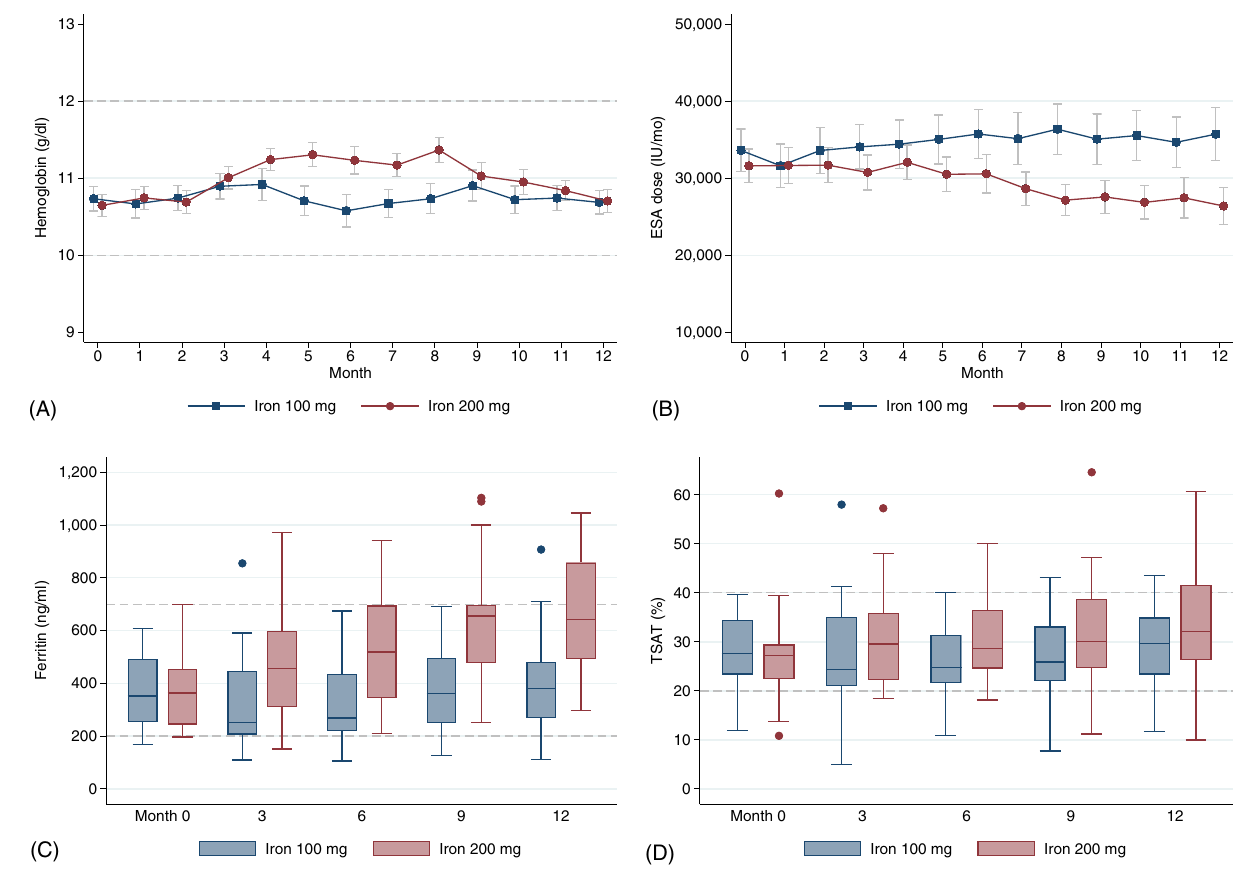
Figure 5. Changes of hemoglobin, ESA doses, ferritin levels, and TSAT by months. ( A ) Hemoglobin change: The target range of hemoglobin level was 10–12 g/dl during the follow-up period (dash bar). The solid bars indicate 95% confidence intervals. ( B ) Monthly erythropoietin dose changes and 95% confidence intervals (solid bars). ( C ) Serial boxplots of ferritin level with the target range of 200–700 ng/ml (dash bar). ( D ) Serial boxplots of transferrin saturation with the target range of 20–40% (dash bar). Abbreviations: ESA, erythropoietin; TSAT, transferrin saturation.